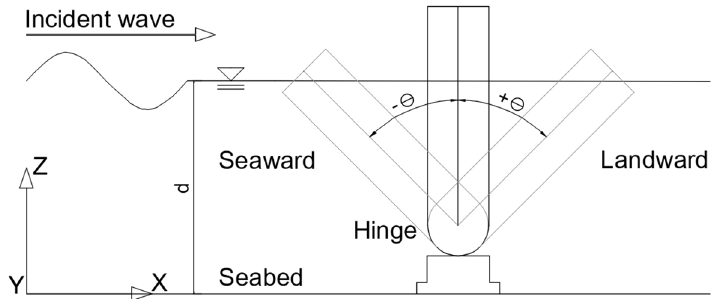
Figure 1. Schematic drawing showing the motion of an oscillating wave surge converter induced by incident waves.